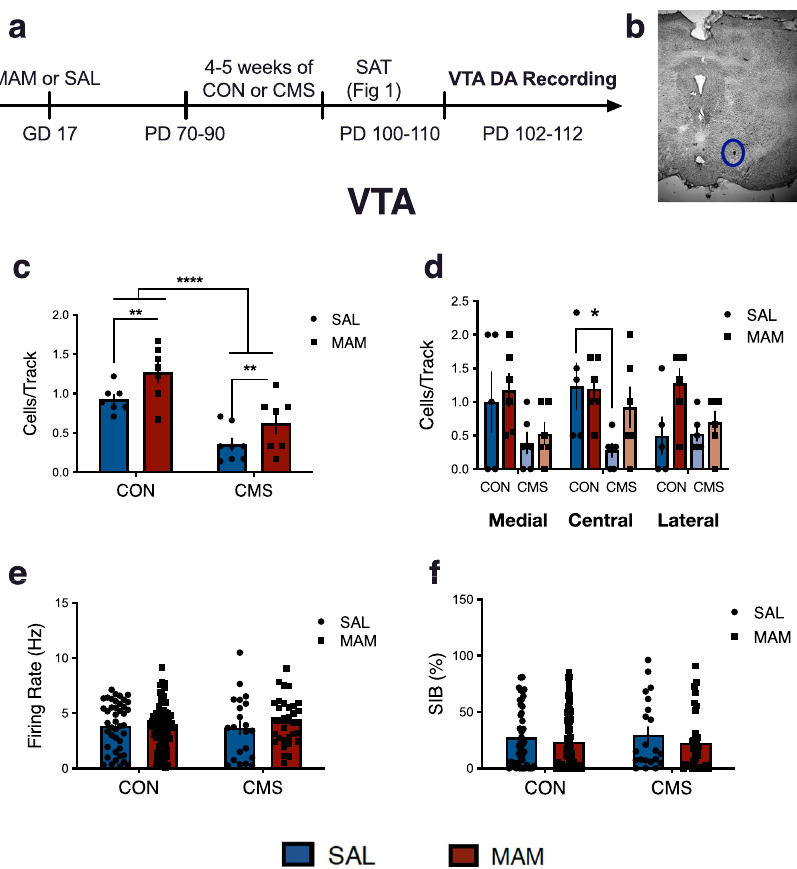
Fig. 2 Adult CMS exposure reduces VTA population activity in both SAL and MAM rats. a Timeline and experimental design. b Representative placement of VTA DA neurons (electrode placement inside blue circle). c Main effects of prenatal MAM treatment (two-way ANOVA: p < 0.01) and adult CMS exposure (two-way ANOVA: p < 0.0001) were found for population activity ( n = 7 – 8 per group). Both groups of MAM animals exhibited increased numbers of spontaneously active VTA DA neurons (i.e. cells/track-CPT) compared to SAL animals. CMS exposure attenuated VTA population activity, as indexed by reduced cells/track in SAL-CMS and MAM-CMS rats compared to standard-housed animals (SAL-CON, MAM-CON). d Population activity was reduced along the central tracks of the VTA in SAL-CMS rats compared to SAL-CON rats ( p < 0.05). e No effect of prenatal MAM treatment ( p = 0.56) or adult CMS exposure ( p = 0.61) was found for basal fi ring rate. f No effect of prenatal MAM treatment ( p = 0.21) or adult CMS exposure ( p = 0.84) was found for percentage of spikes occurring in bursts (SIB%). Error bars represent mean ± SEM. Blue bars and circles represent SAL animals; red bars and squares represent MAM animals. CON groups are plotted on the left and CMS groups are plotted on the right. * p < 0.05, ** p < 0.01, **** p <